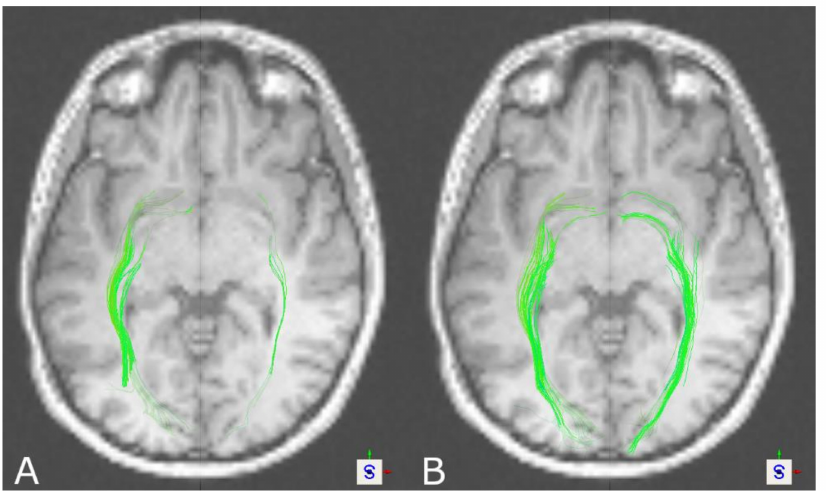
Figure 3. Tractography results of the OR for a healthy volunteer based on DTI ( A ) and DKI ( B ), showing more solid and compound tract reconstructions in the case of DKI (axial